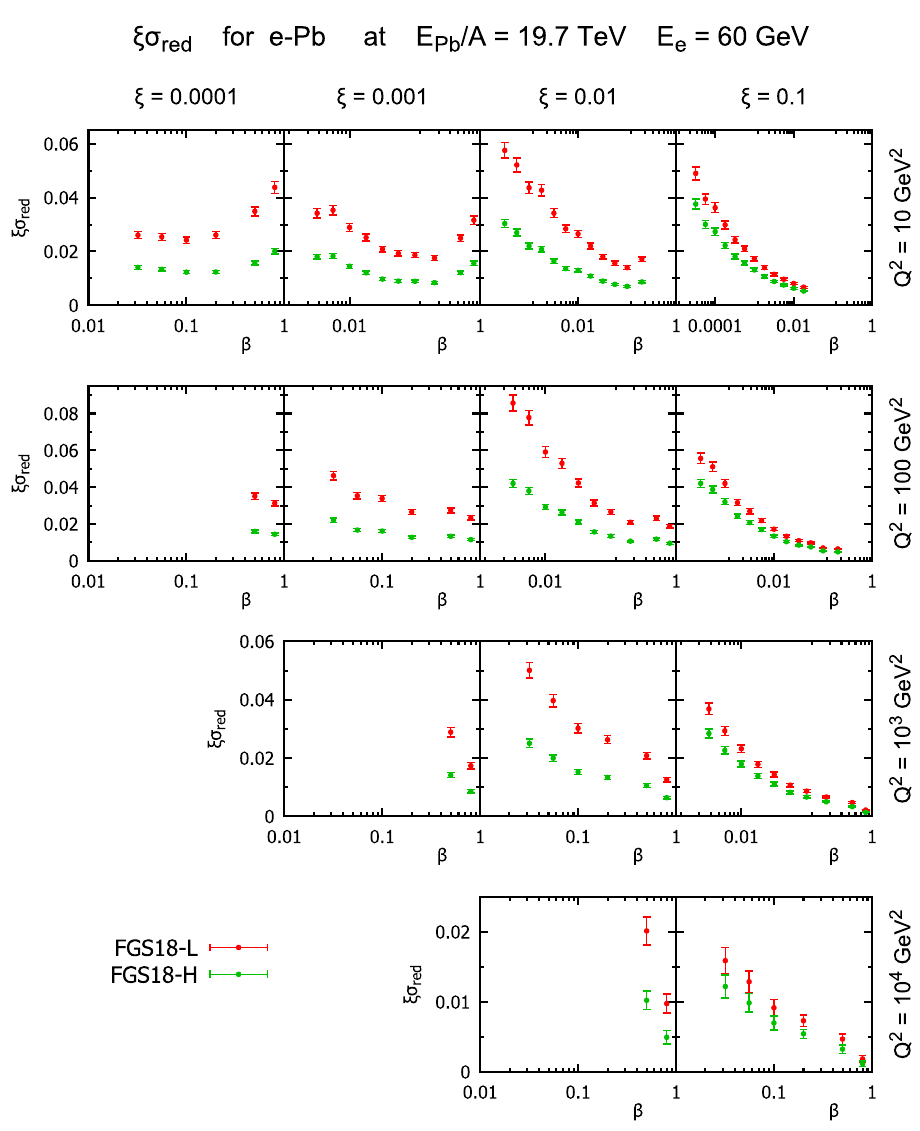
value ( ∼ 50) in order to accommodate data from different experiments and types of collisions. Note also that in present analysis the glue is basically unknown both for x < 0 . 01 and for x > 0 . 2, with the shape of the uncertainty band dictated by the functional form of the initial conditions